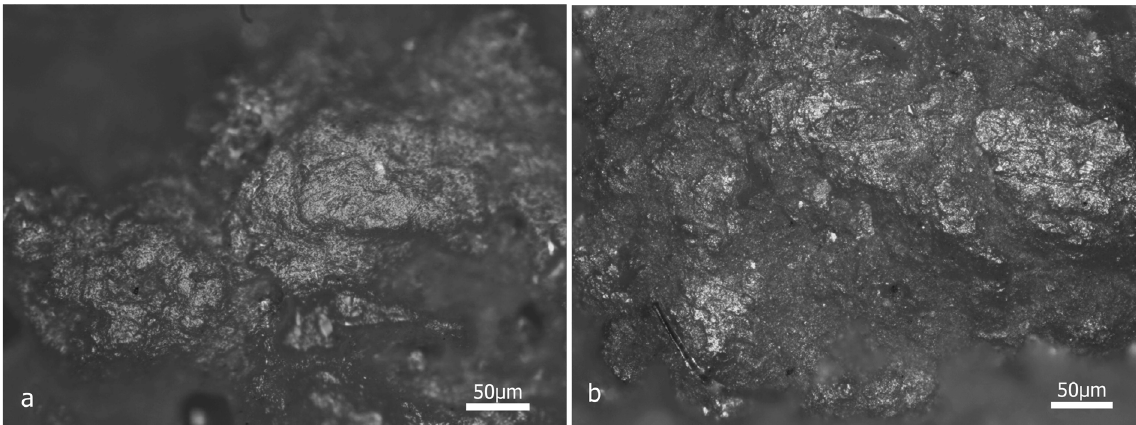
Figure 12. Polish traces on querns from goethite processing as seen with the metallographic microscope: a. experimental traces; b. archaeological